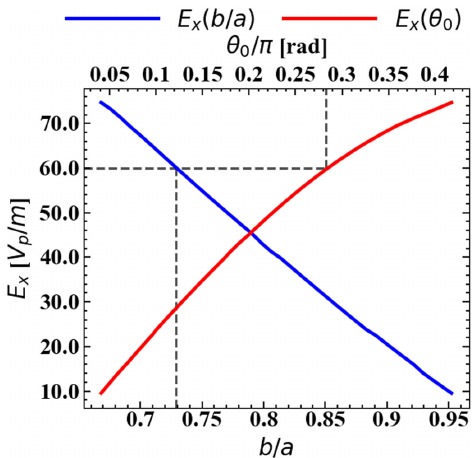
FIG. 7. The odd mode electrical field E at the center as a x functionof ð b=a; θ 0 Þ .Theaxesarelabeledasfollows;bottom: b=a , =m where V in units of V is thevoltage on the top: θ 0 , vertical: E x p p plates. The beam pipe radius a ¼ 25 mm. The even mode 50 Ω is constant along each characteristic impedance Z c ¼